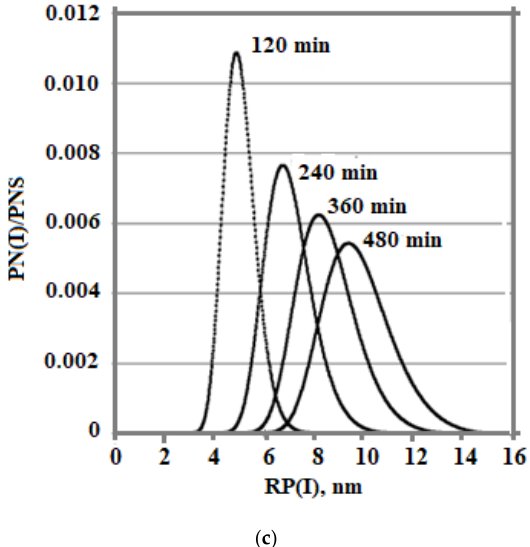
Figure 9. The time dependences of the concentration of dissolved silicic acid C S ( a ), supersaturation ( b ), and particle size distribution ( c ). The temperature decreases from 100 to 20 °C, рН = 8.0, and C S = 700 mg/kg.